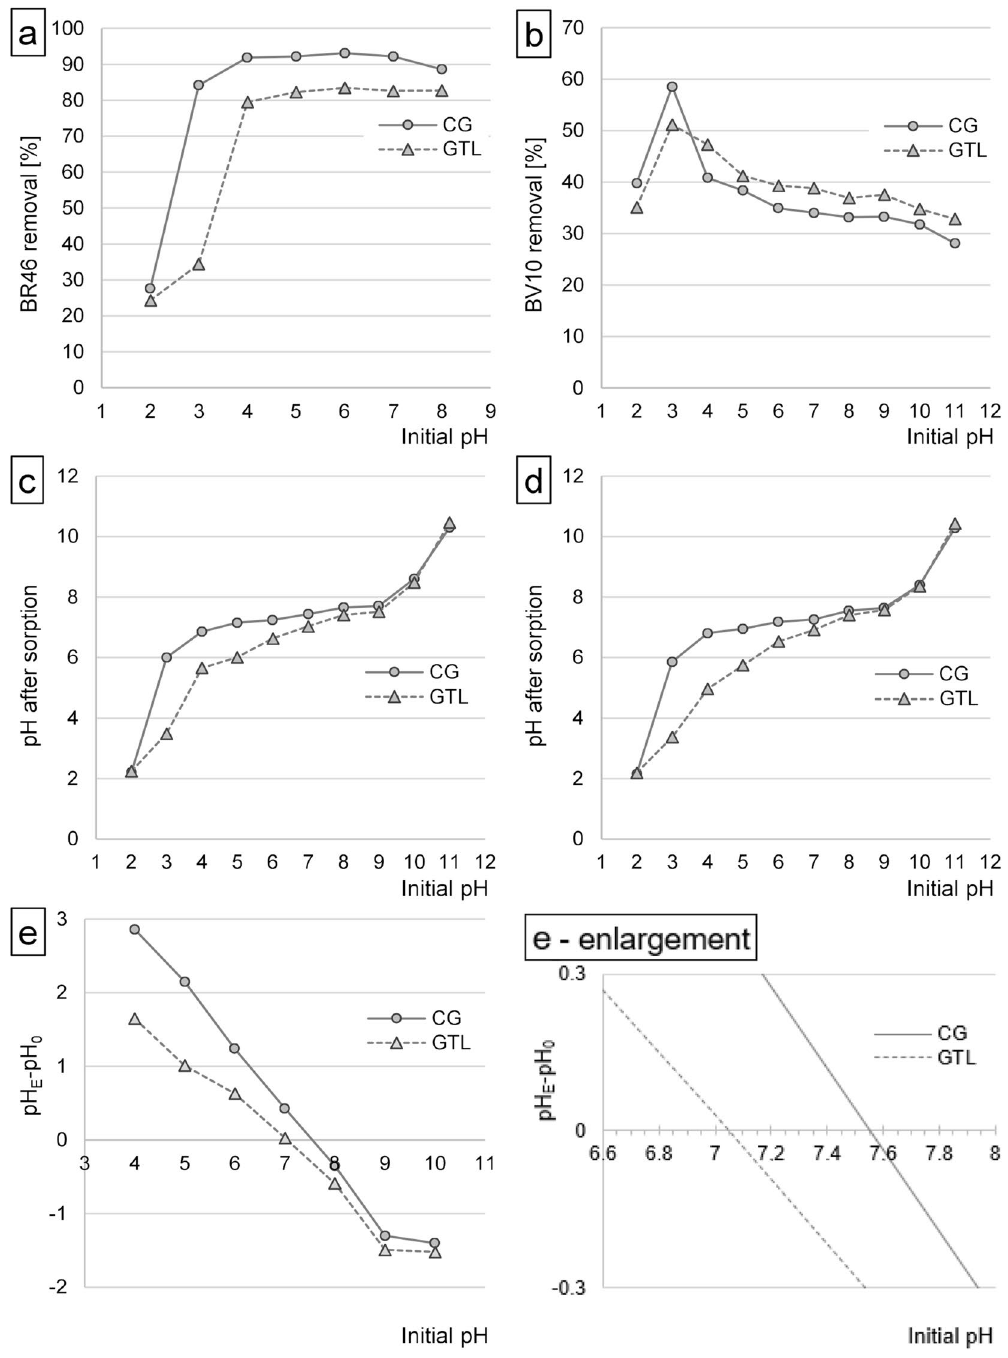
Figure 2. Effect of pH on the effectiveness of sorption of ( a ) BR46, and ( b ) BV10 onto CG and GTL. Effect of CG and GTL on changes in solution pH after sorption of: ( c ) BR46, and ( d ) BV10. ( e )/e-enlargement)— Determination of pH PZC of the sorbents (CG/GTL) with the Boehm’s titration method. Temp. 22